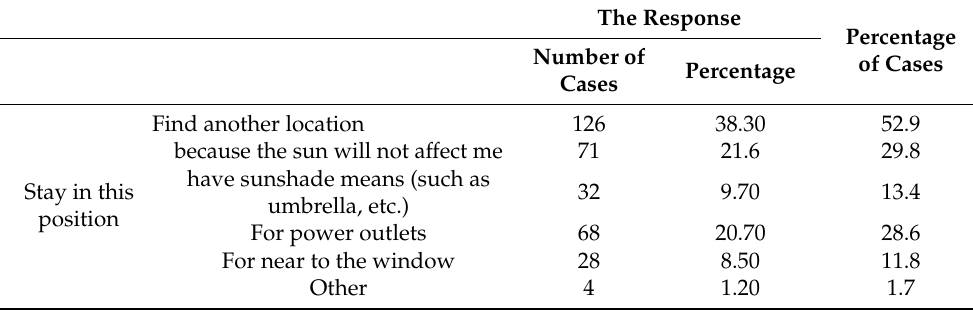
Table 3. When the seat you want is directly exposed to the sun, what choice will you make?